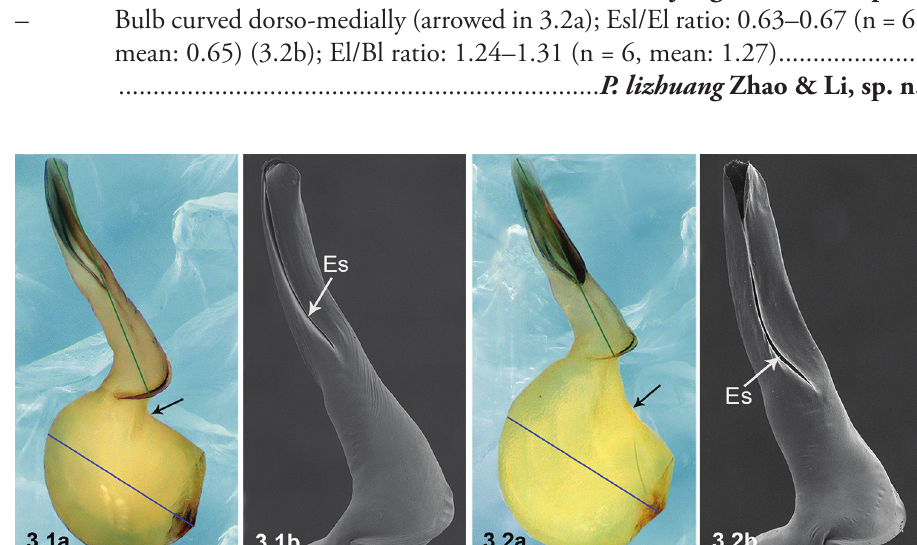
Bulb curved dorso-distally (arrowed in 3.1a); Esl/El ratio: 0.51–0.55 (n = 5, mean: 0.53) (3.1b); El/Bl ratio: 1.47–1.54 (n = 5, mean: 1.49) .................... – Bulb curved dorso-medially (arrowed in 3.2a); Esl/El ratio: 0.63–0.67 (n = 6, mean: 0.65) (3.2b); El/Bl ratio: 1.24–1.31 (n = 6, mean: 1.27)